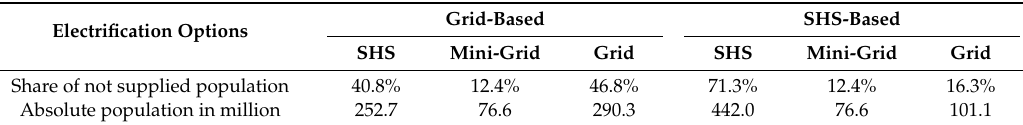
Table 2. Quantification of electrification options depending on excluding (grid-based) and including (SHS-based) the population density within the grid buffer zone based on the existing grid